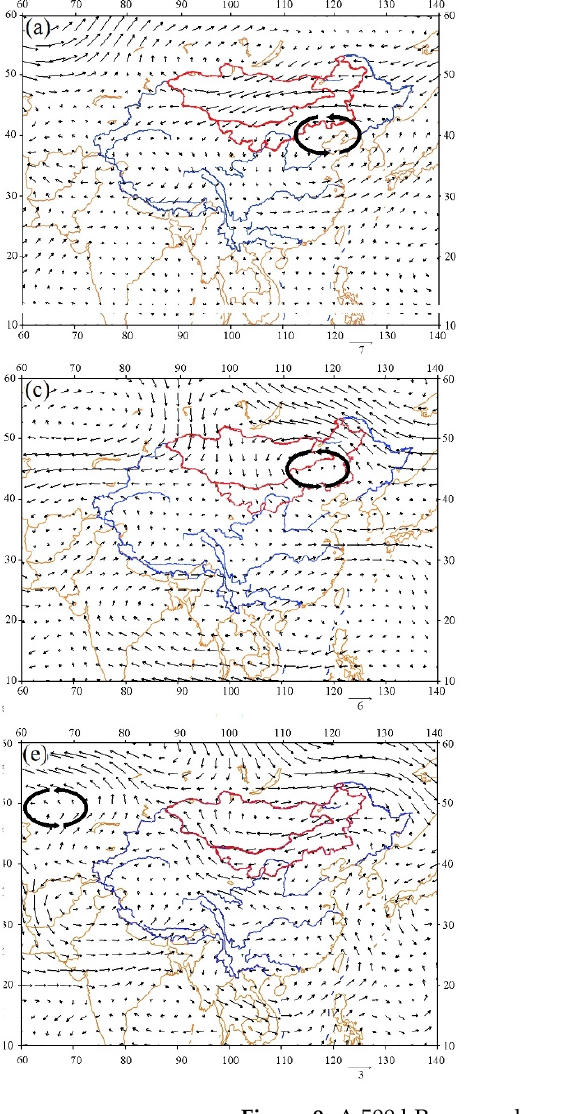
Figure 9. A 500 hPa anomalous wind field in summer (unit: m/s) (( a ) 2015, ( c ) 1998, ( e ) 2005) and troposphere (1000–300 hPa) integral water vapor transport and convergence and divergence fields. The vector is the water vapor transport anomaly, unit kg/(s · m), the shaded area is the water vapor transport convergent divergent anomaly, unit 10 − 5 kg/(s · m 2 ) (( b ) 2015, ( d ) 1998, ( f ) 2005) (the pink, purple, and green arrows indicate the directions of the India-Pacific, Pacific, and Arctic Ocean water vapor to the arid region).